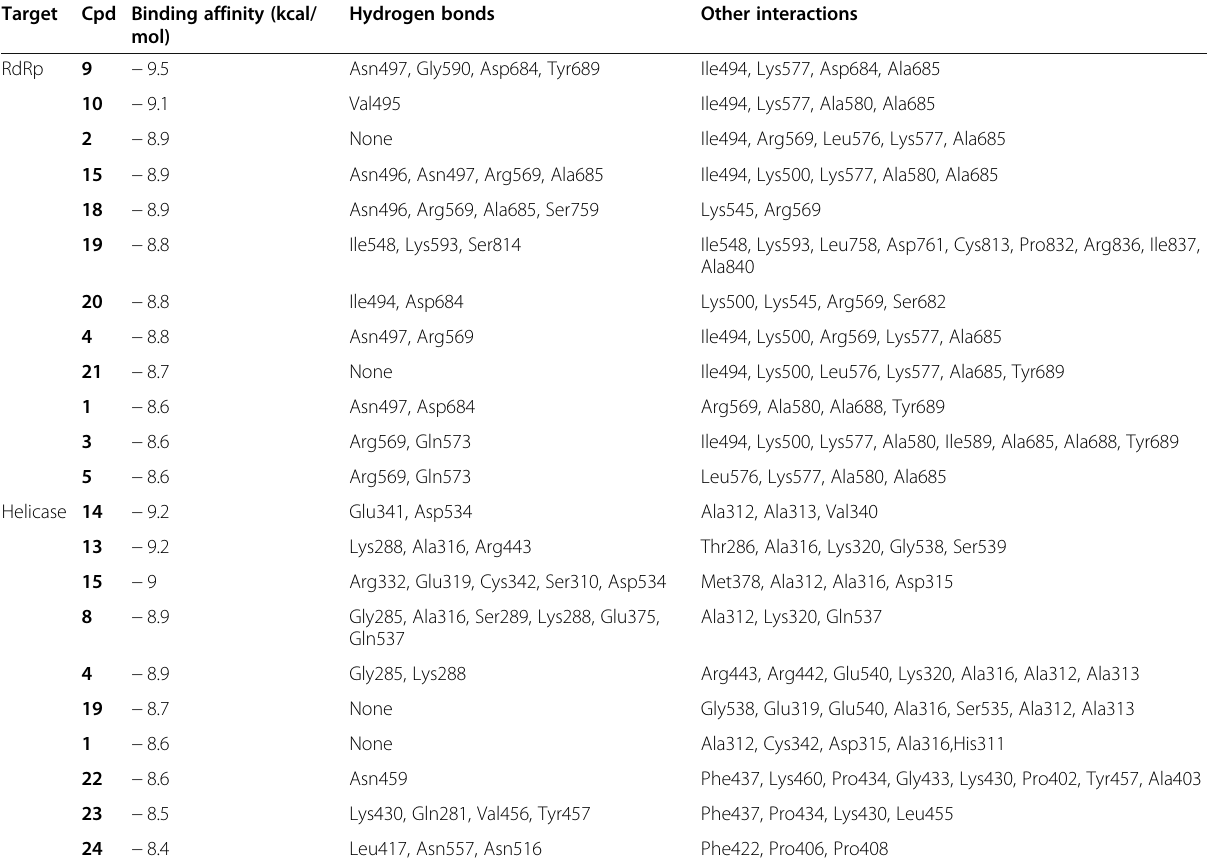
Table 2 Binding affinities and interactions of top ten ligands against the nsps vital for replication Target Cpd Binding affinity (kcal/ Hydrogen mol)